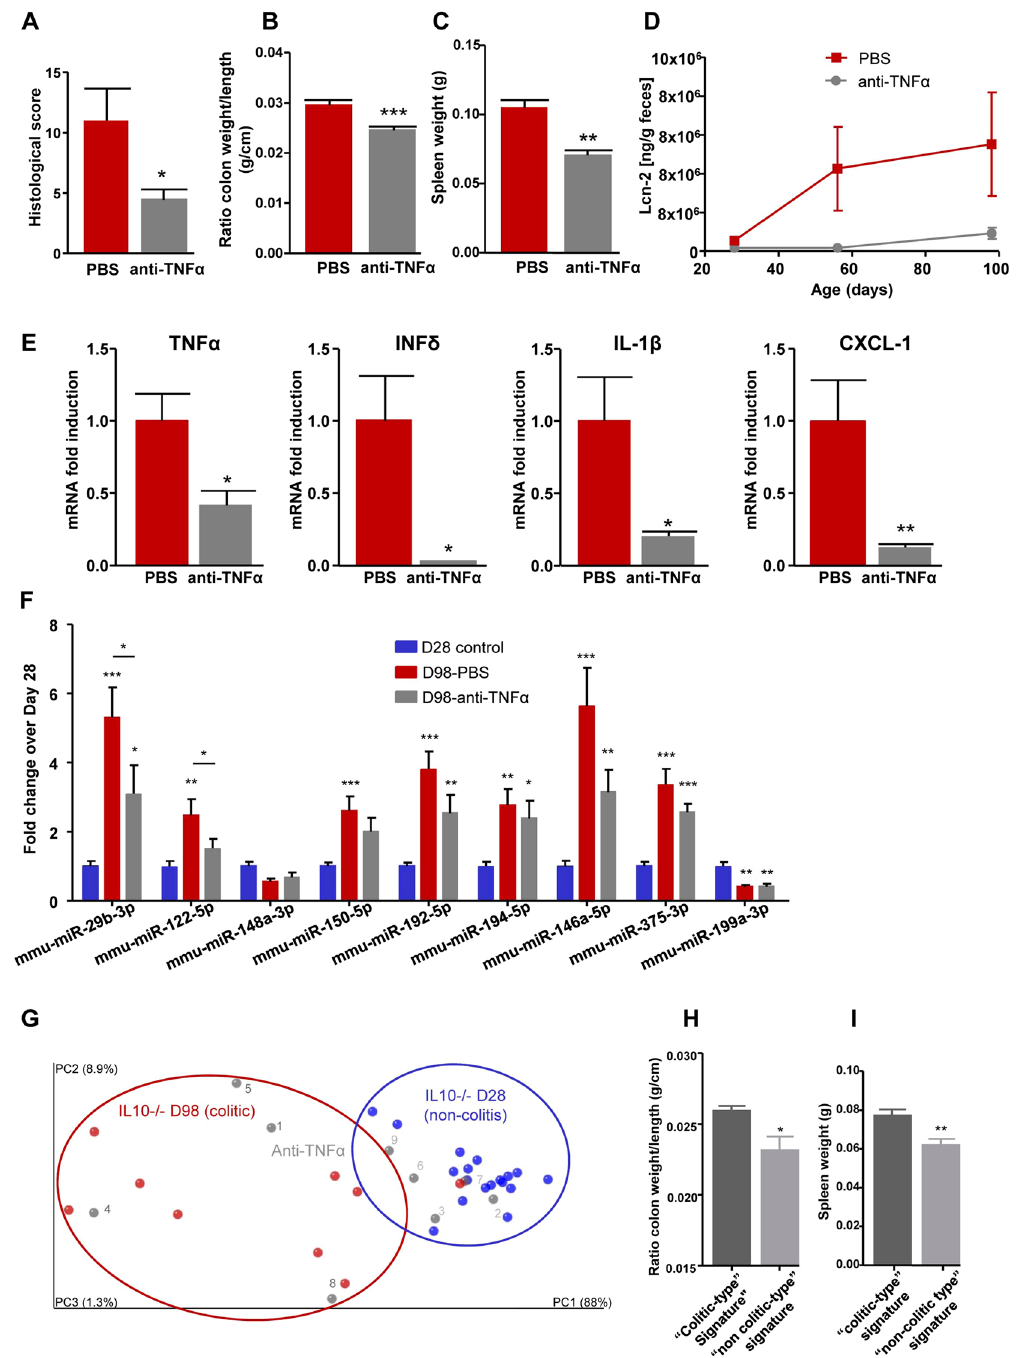
Figure 5. The miRNA signature in the evaluation of therapeutic response. IL10 − / − mice were treated by IP injection of anti-TNF α antibodies at a dose of 10 mg/kg two times per week for 10 weeks. ( A ) Histological scores were measured from H&E-stained colons (Fig. S7A). ( B – D ), spleen weight ( B ), ratio of colon weight/colon length ( C ), and fecal Lcn-2 ( D ) were measured. ( E ) Total RNAs were extracted from colons, and the expression levels of TNF α , IFN- δ , IL-1 β and KC were quantified by qPCR and normalized with respect to 36B4. ( F ) The fold changes of the nine signature miRNAs were quantified by qPCR in the sera of IL10 − / − mice. ( G ) PCoA of the euclidean distance matrix of miRNA expression in sera from D28 IL10 − / − mice (blue), D98 IL10 − / − PBS-treated (red) and day 98 IL10 − / − anti-TNF α -treated (gray) mice. Percentages on the axes indicate the percentage of variance explained by each component. ( H , I) ratios of colon weights/colon lengths ( H ) and spleen weights ( I ) of mice with the colitic-type signature (dark gray) and non-colitic-type signature (light gray) are displayed as bar graphs. Data are presented as the means + / − S.E.M. (n = 9). Significance was determined using an unpaired t-test ( A,B,C,E,H,I and J ) or One-way ANOVA followed by a Bonferroni post-test ( F ) ( * p < 0.05; ** p < 0.01; *** p < 0.001) compared to the day 98 IL10 − / − PBS control group ( A – E ) or day 28 IL10 − / − control group ( F